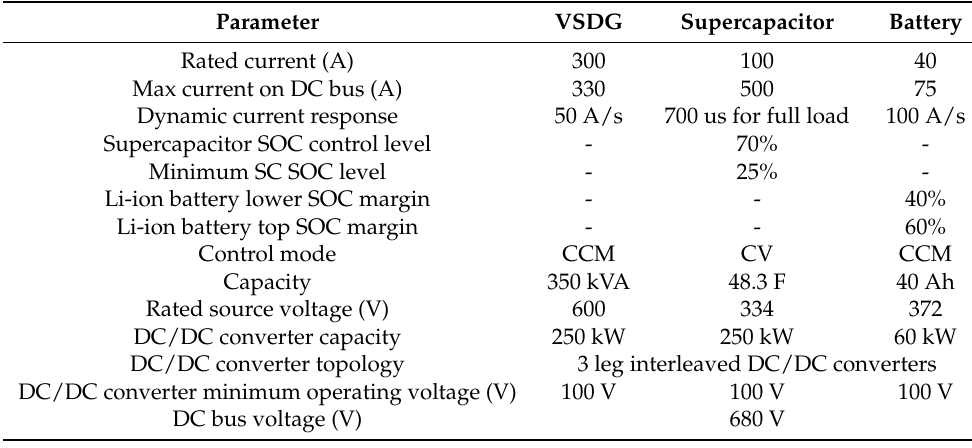
Table A1. Model parameters of proposed hybrid